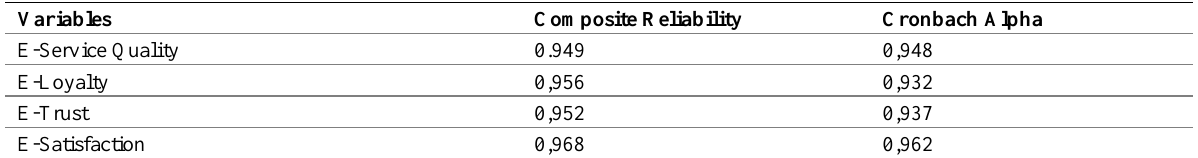
Table 1: Composite Reliability, Cronbach Alpha, AVE